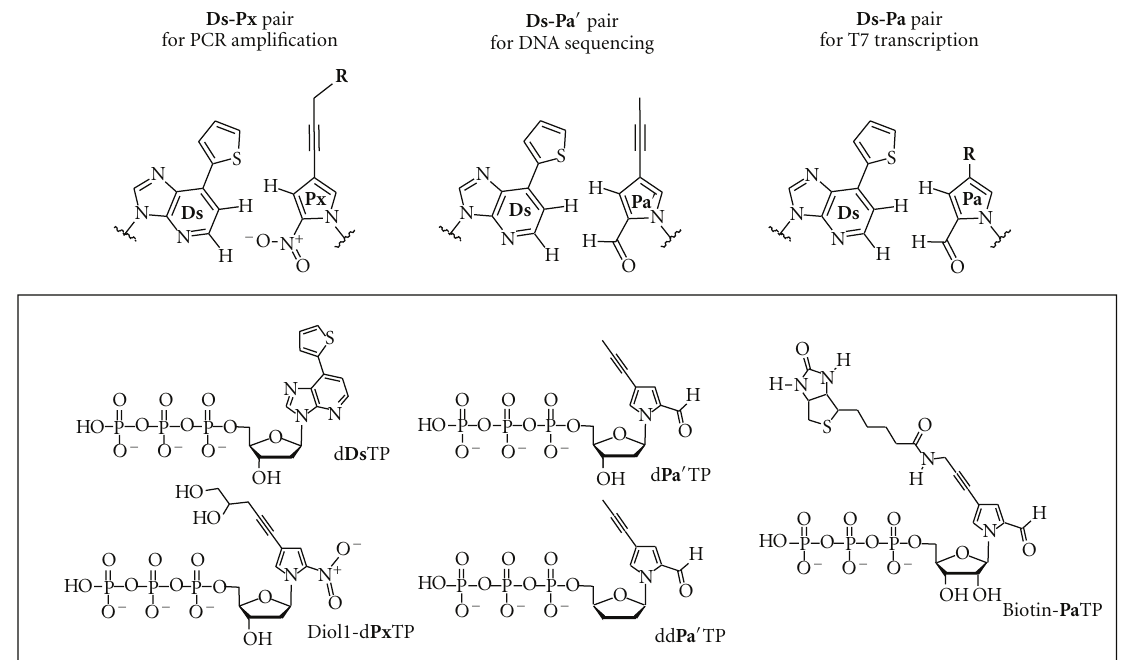
Figure 1: Chemical structures of the Ds - Px , Ds - Pa (cid:3) , and Ds - Pa pairs. The Ds - Px pair is employed for PCR amplification to prepare the Ds -containing DNA templates. The Ds - Pa (cid:3) pair is employed for DNA sequencing, to determine the Ds position in the DNA templates. The Ds - Pa pair is employed for T7 transcription, to incorporate Biotin- Pa into RNA opposite Ds in the templates. Px and Pa bases modified with various functional groups (R) can also be used as substrates for PCR and transcription, respectively. The unnatural substrates used in this study are summarized in the